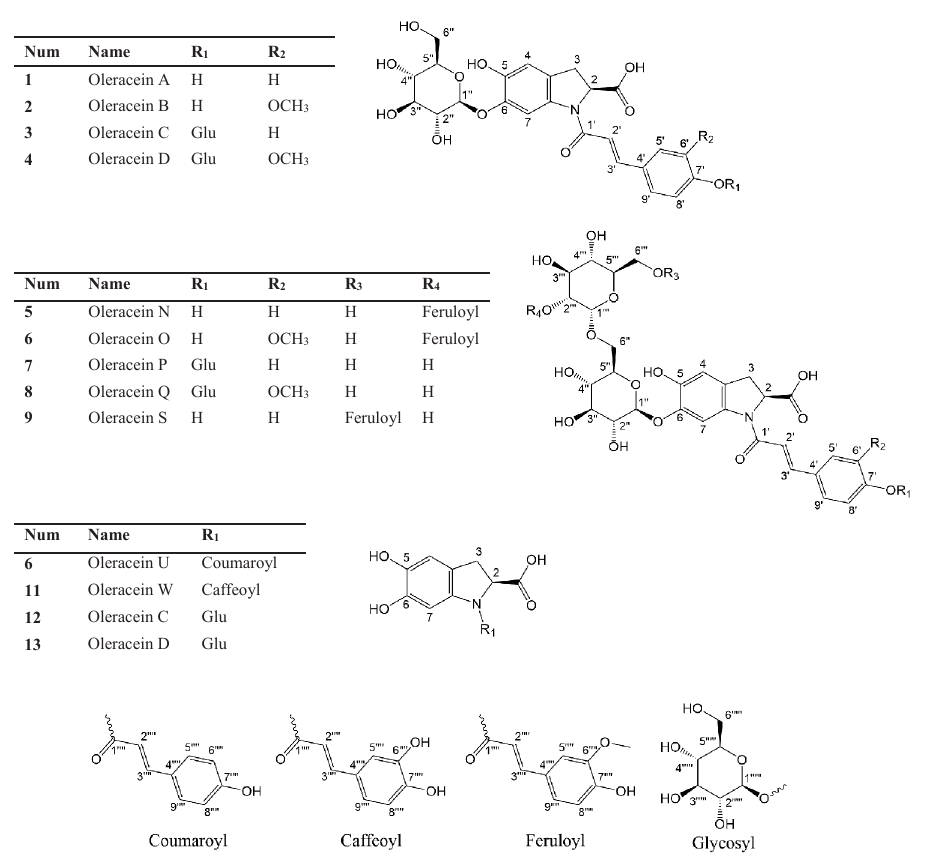
Fig. 6: Chemical structure of tentatively identified Oleraceins A-D, N-Q, S, U and